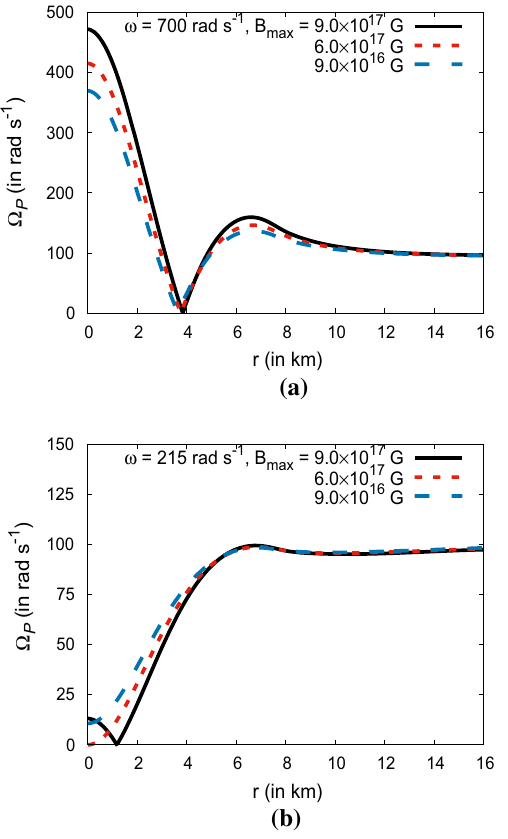
Fig. 24 a Ω P of the gyro around a rotating and magnetized NS with different values of ω and with a fixed value of B . The black solid line is for a extreme rotating magnetized NS. The red short dashed curve is for a highly rotating and magnetized NS. The blue dashed line is for a moderately rapidly rotating NS. The green dot dashed curve is for a slowly rotating NS. The value of Ω is taken to be 100 rad s − 1 . b Nature of Ω P for different values of Ω around a rotating and magnetized star ( ω = 700 rad s − 1 and B max = 6 × 10 17 G ). The black solid line, red short dashed line and blue dashed line are for Ω = 100 rad s − 1 , 300 rad s − 1 and 350 rad s − 1 respectively